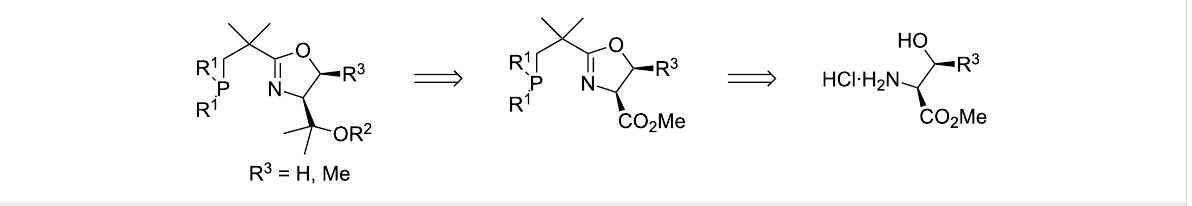
Figure 4: Retrosynthetic analysis for NeoPHOX ligands derived from serine and threonine.